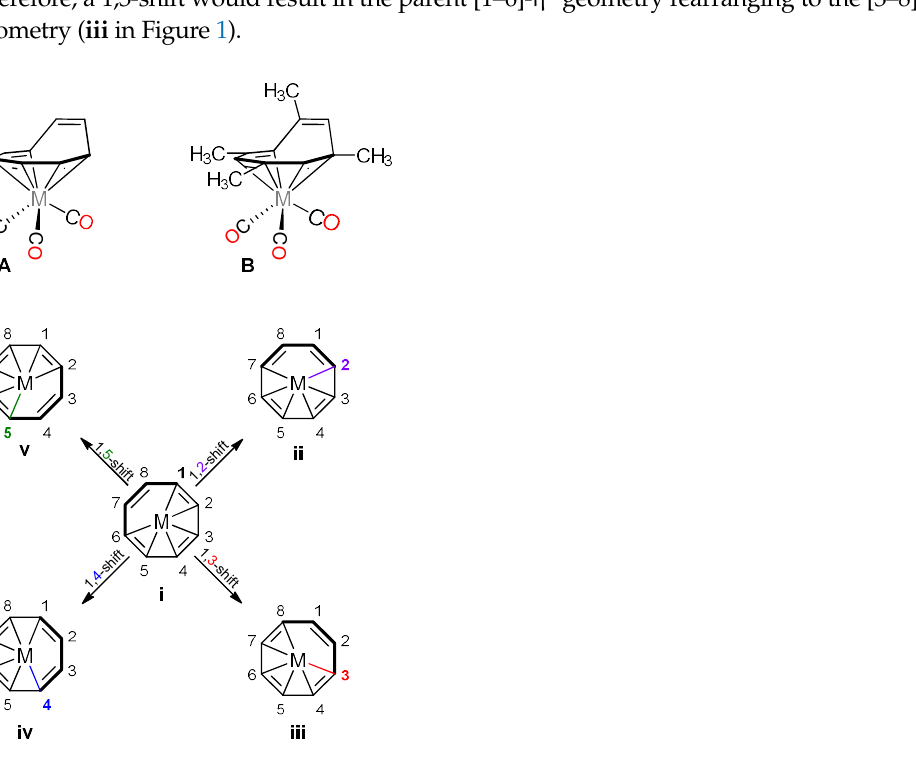
Figure 1. Two-dimensional representations of generalized COT ( A ) and TMCOT ( B ) piano-stool complexes. 1, n -shift ( n = 2, 3, 4, 5) in (COT) M (CO) 3 /(TMCOT) M (CO) 3 . CO, H, and CH 3 groups omitted for clarity ( i – v ).